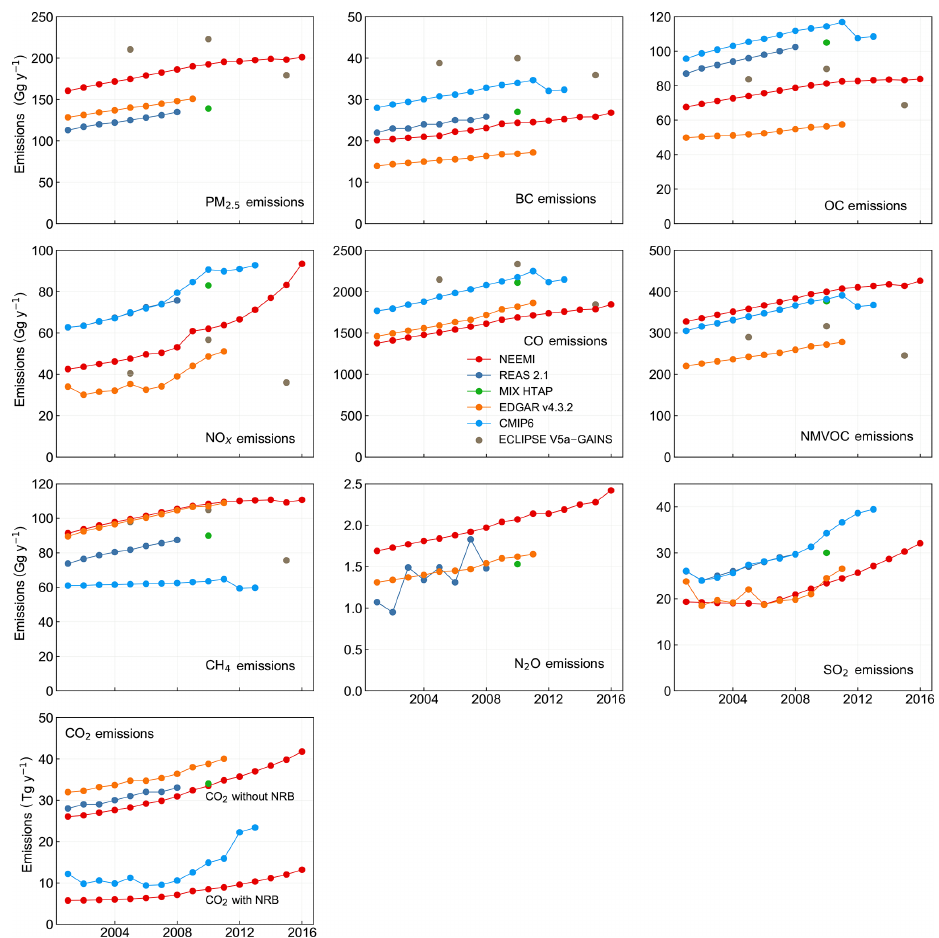
Figure 7. Emission comparison with EDGAR, CMIP6, ECLIPSE–GAINS, REAS and MIX HTAP emission inventories. CO 2 emissions with and without non-renewability fraction for biomass (NRB) are also shown for comparison. Table 3. Comparison of NEEMI-Tech emissions with the MIX HTAP emissions for 2010. Sectors CO 2 CH 4 N 2 O NO x CO NMVOCs PM 2 . 5 BC OC SO 2 NEEMI (2010) 33.4 1689 Ratio